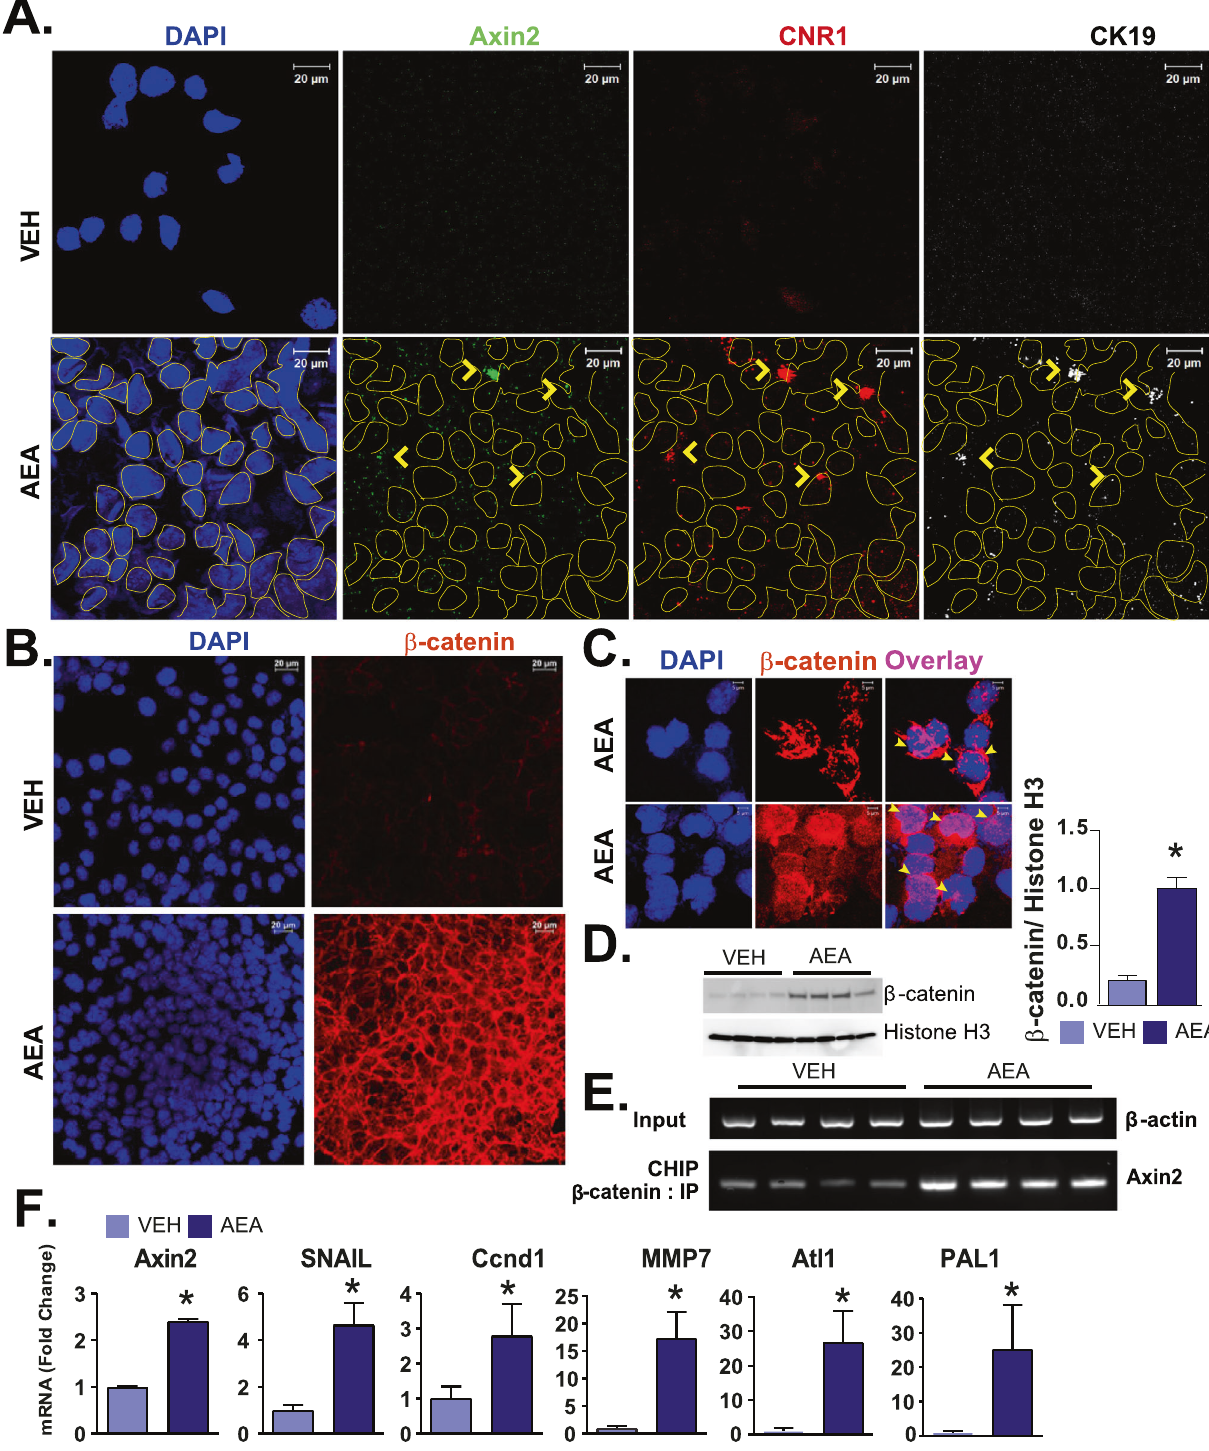
Fig. 3 AEA-induced co-expression of Axin2, CB 1 R, and CK19 ( Krt19 ) mRNA, as well as that for β -catenin and its target genes, in mouse HPCs. A RNAscope analyses of the effect of AEA (300 nM) on the expression of Axin2, Cnr1 , and CK19 and in BMOL. Yellow arrows in panel A illustrate co-expression of the three mRNAs in the same cell. Co-expression is also illustrated by an overlay. B , C Effect of AEA (300 nM) on β -catenin protein localization in the nuclear membrane/nucleus in BMOL cells, as visualized by confocal immuno-histochemistry, including two sets of overlaid images at higher magni fi cations for AEA group. D Immunoblot analyses of β -catenin from nuclear fraction obtained four independent experiments and their quanti fi cations. Histone H3 was used as a nuclear fraction validation marker. E CHIP analyses of Axin-2 promoter pulled by β -catenin antibody. Input DNA control was validated by β -actin. F Real-time PCR analysis of AEA induction of β -catenin target genes Axin2, Mmp7, Snail, Ccnd1 , Atl1 , and PAI1 ( n = 3/groups, * P < 0.05 compared to vehicle-treated cells.